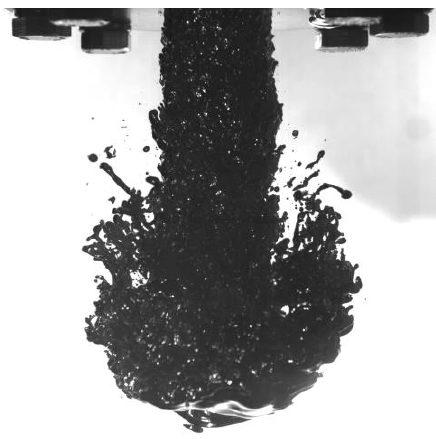
Figure 1. Woods metal jet breakup in water: T j = 85 °C, T l = 40 °C, D j = 50 mm, V j,in = ~1.0 m/s [13].